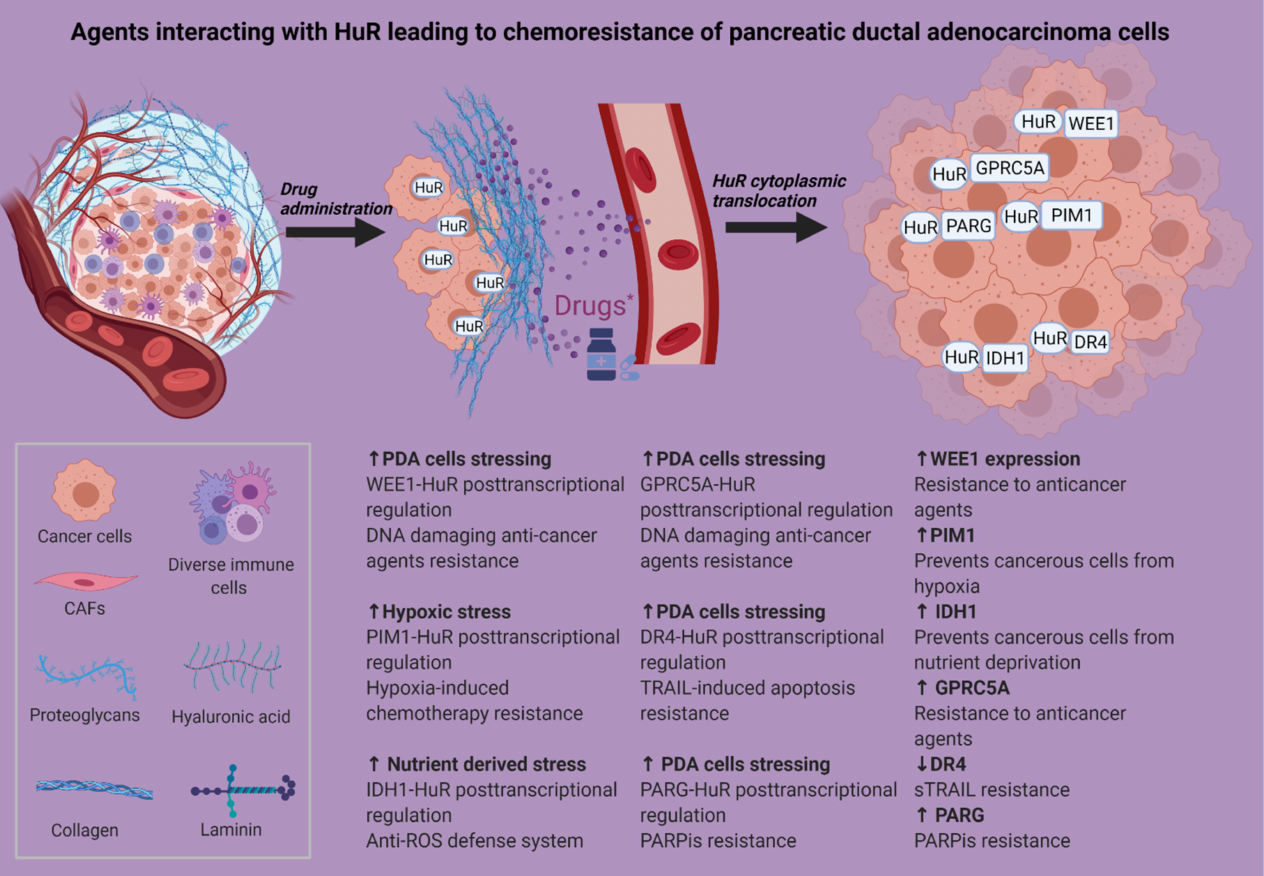
Figure 2. Agents interacting with HuR causing chemoresistance of pancreatic ductal adenocarcinoma cells. Created with BioRender. Abbreviations in Figure 2: CAFs: cancer-associated fibroblasts; DR4: death receptor 4; ECM: extracellular matrix; GPRC5A: G protein-coupled receptor class C group 5 member A; HuR: human antigen R; IDH1: isocitrate